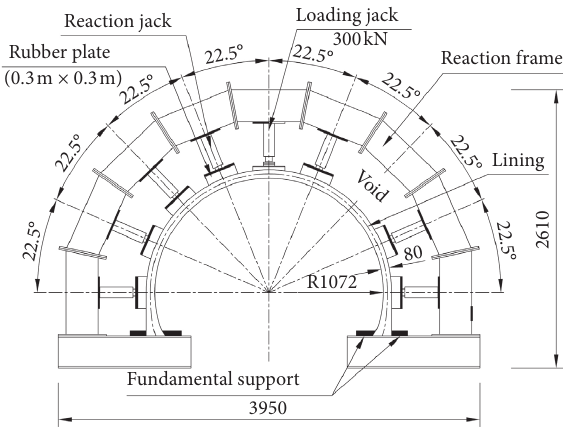
Figure 1: Experimental loading device (unit: